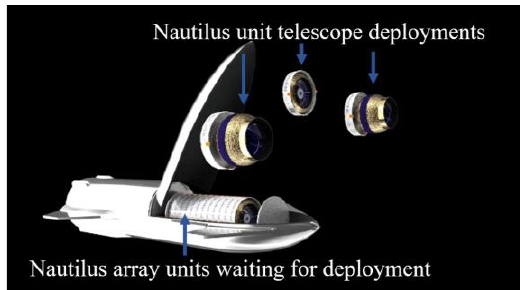
Fig. 2. MODE lens consisting of two engineered